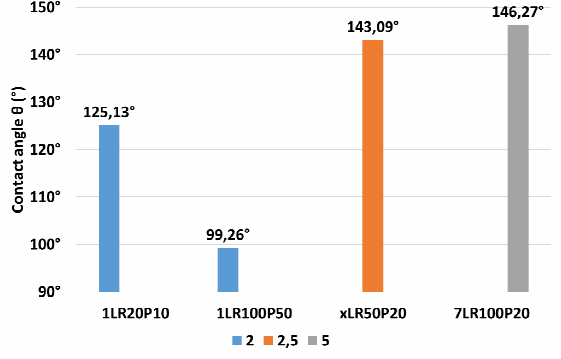
Fig. 11. Influence of the R/P